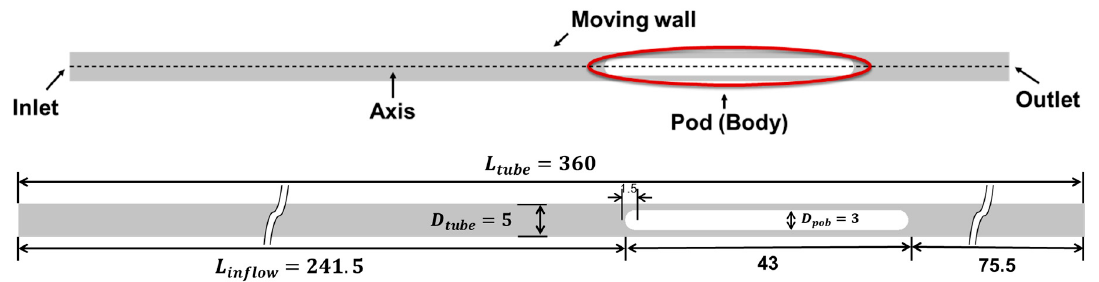
Figure 2. Boundary conditions and schematic of the computational model (unit: m) for BR = 0.36 ( D tube = 6 m for BR = 0.25).